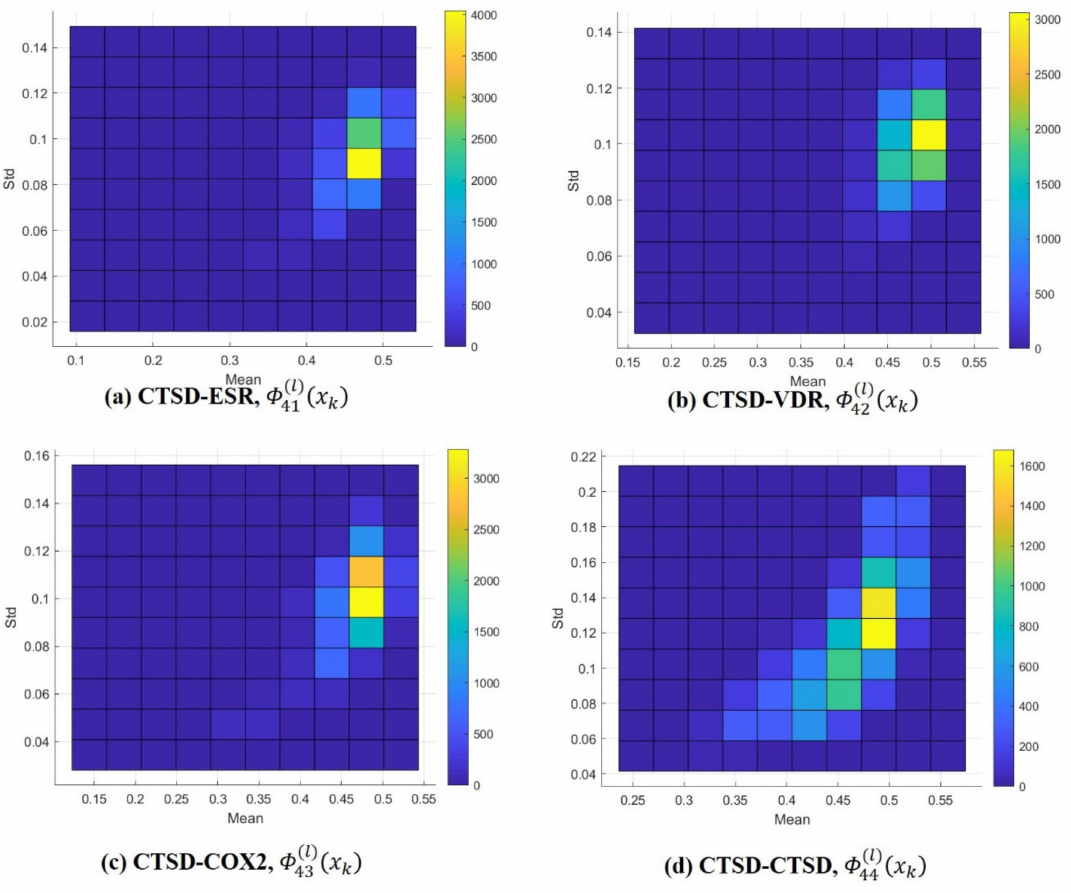
(cid:18) (cid:19) (cid:12) (cid:12) Φ ( l ) ω , µ , σ ,1 ( x ) (cid:12) estimates ( µ 1 and σ 1 ). Query ( l ) ∈ CTSD (cid:12) g , k 4 n